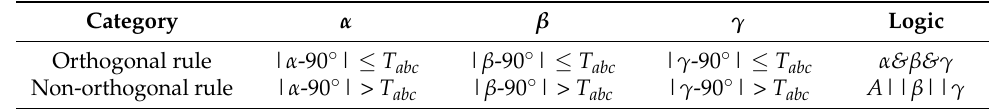
Table 1. The orthogonal rules defined for motion trajectory lines.